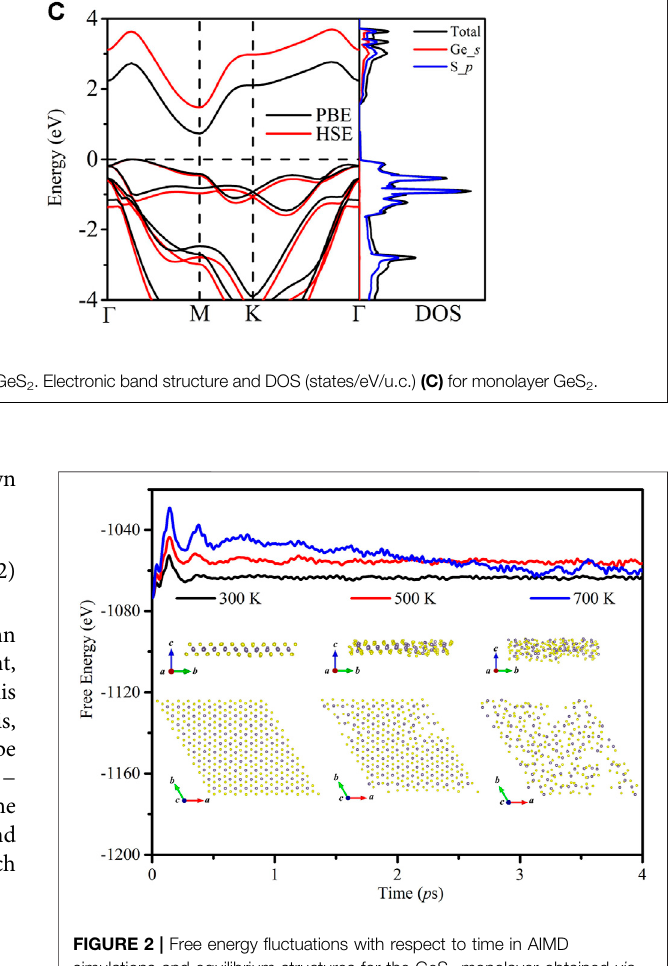
FIGURE 2 | Free energy fl uctuations with respect to time in AIMD simulations and equilibrium structures for the GeS 2 monolayer obtained via AIMD simulations at 300, 500, and 700